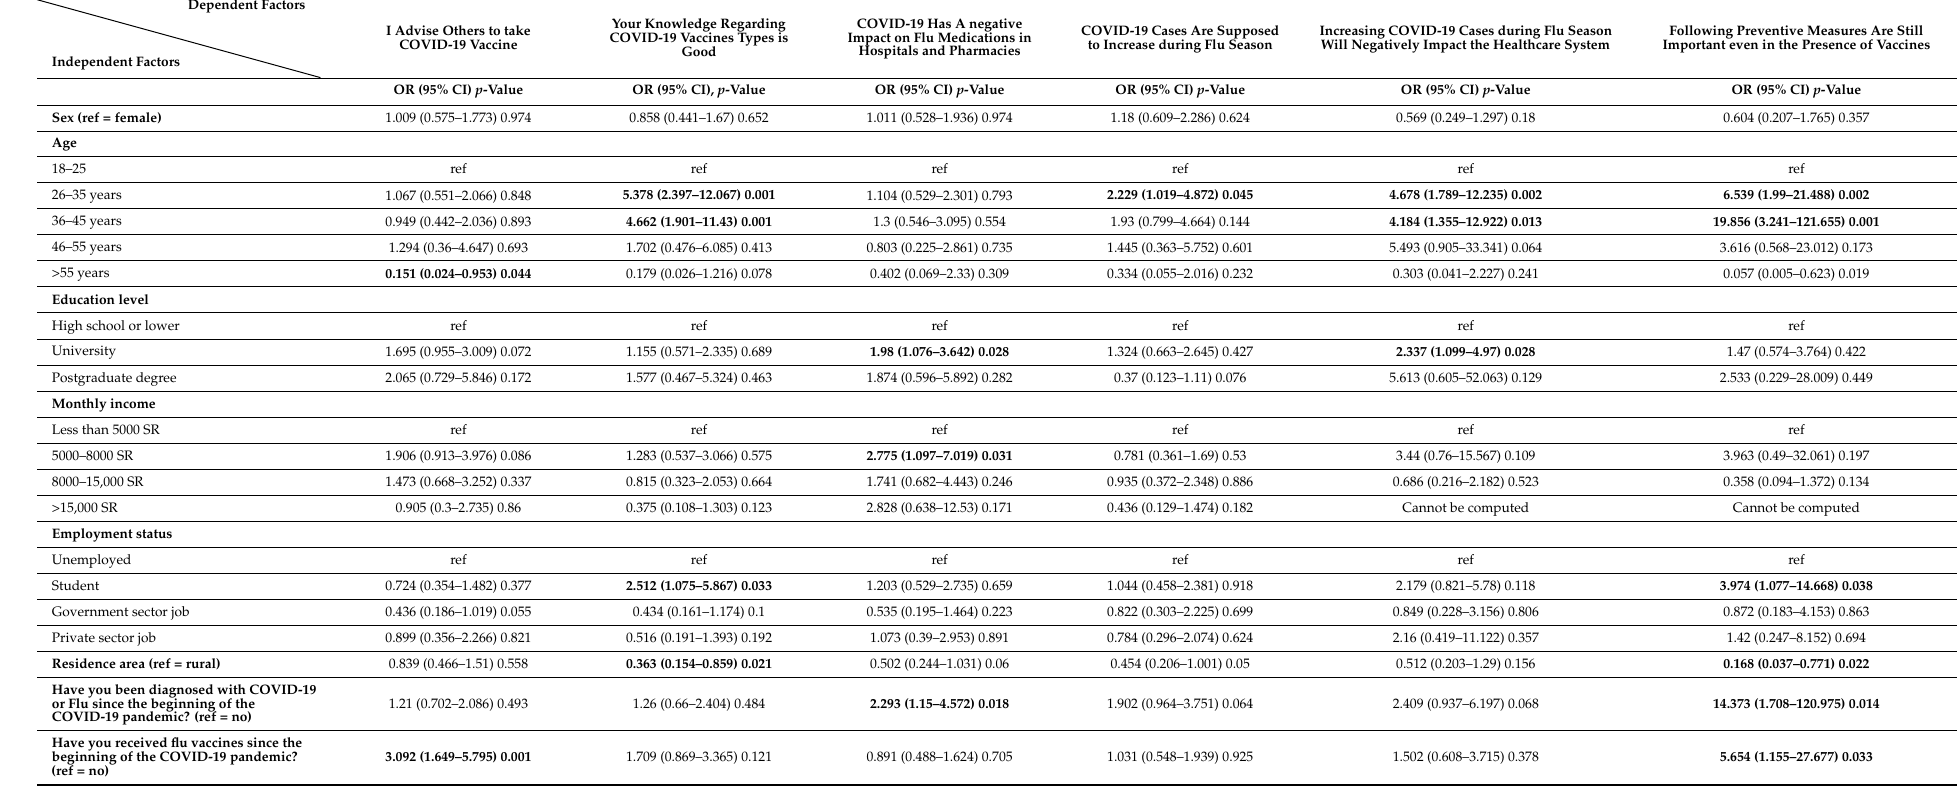
Table 4. A logistic regression model examining factors affecting sufficient knowledge towards flu and COVID-19